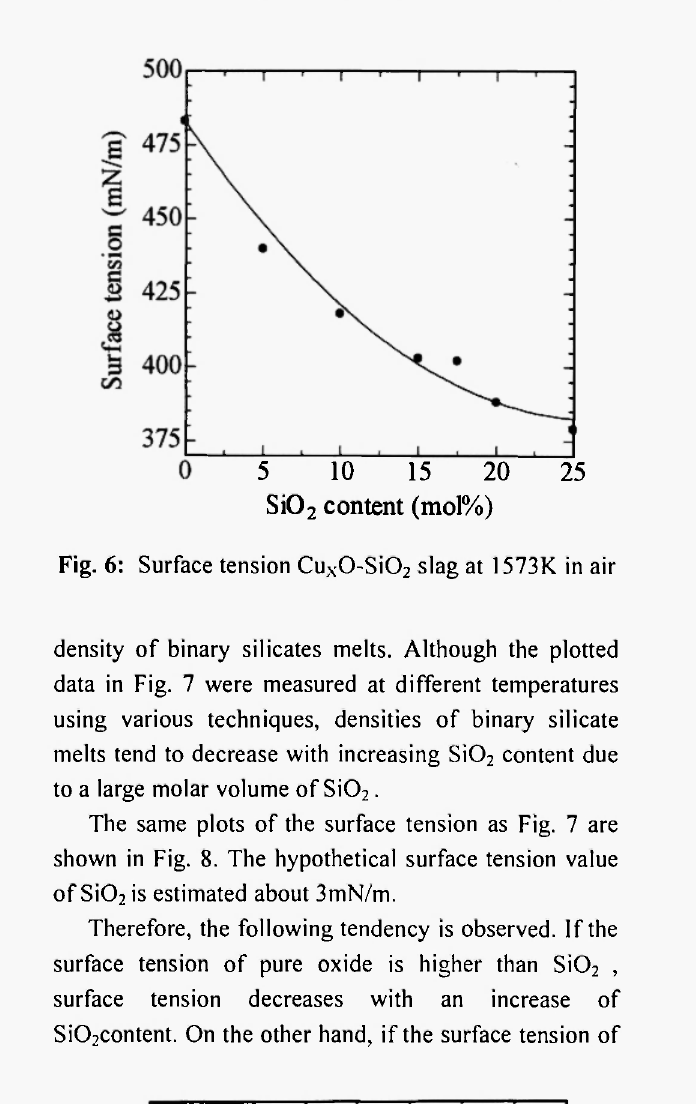
Fig. 5: Density of Cu x 0-Si0 2 slag at 1573K in air